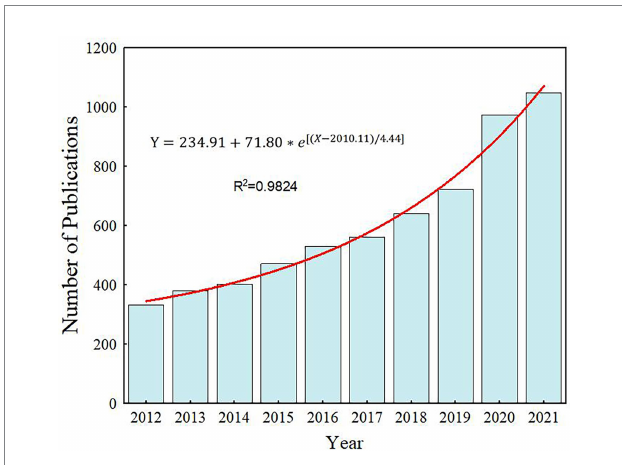
FIGURE 2 The distribution of publications on rhizosphere microorganisms from 2012 to